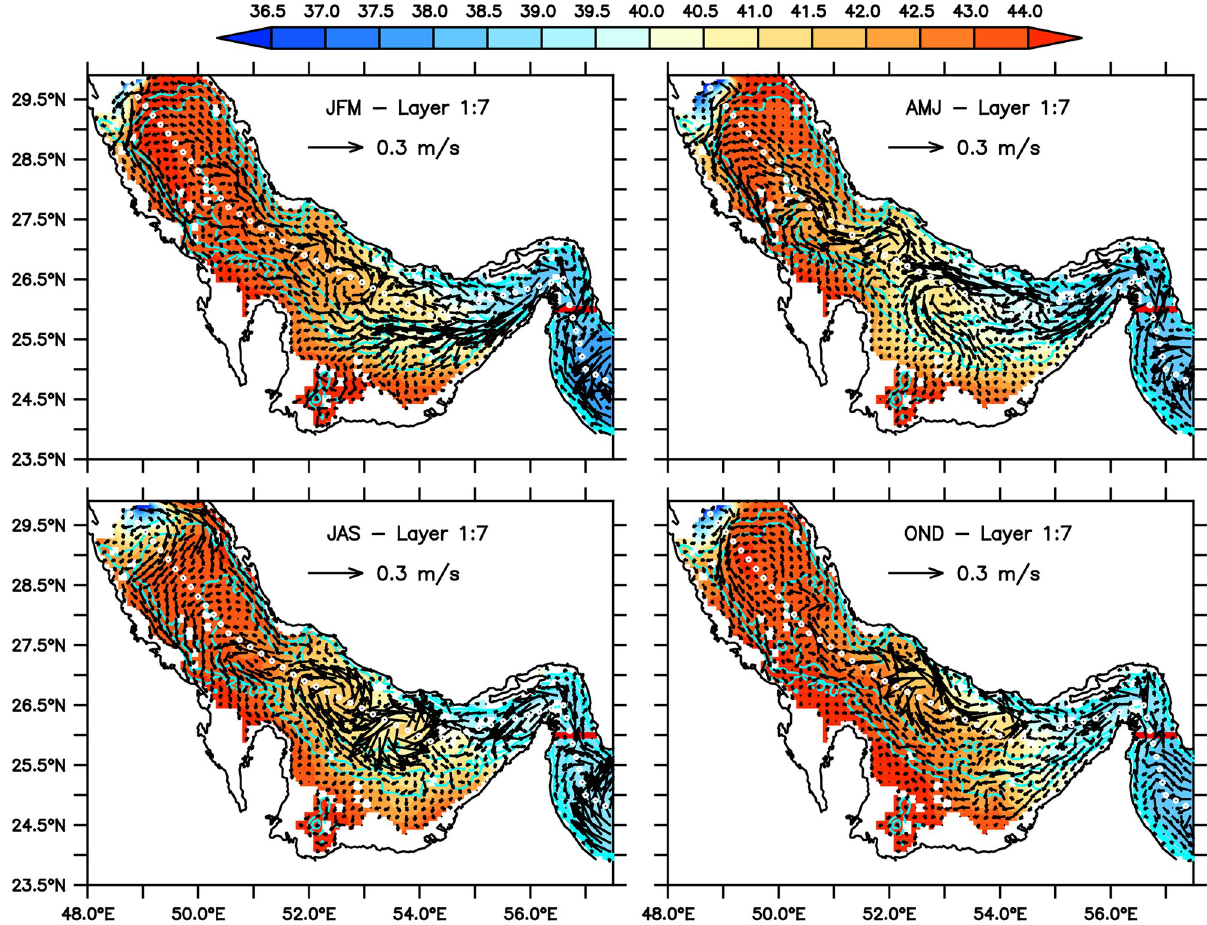
Fig 3. Seasonal mean distributions of salinity and velocity averaged over the upper seven layers of the model (mean depth of 25m).